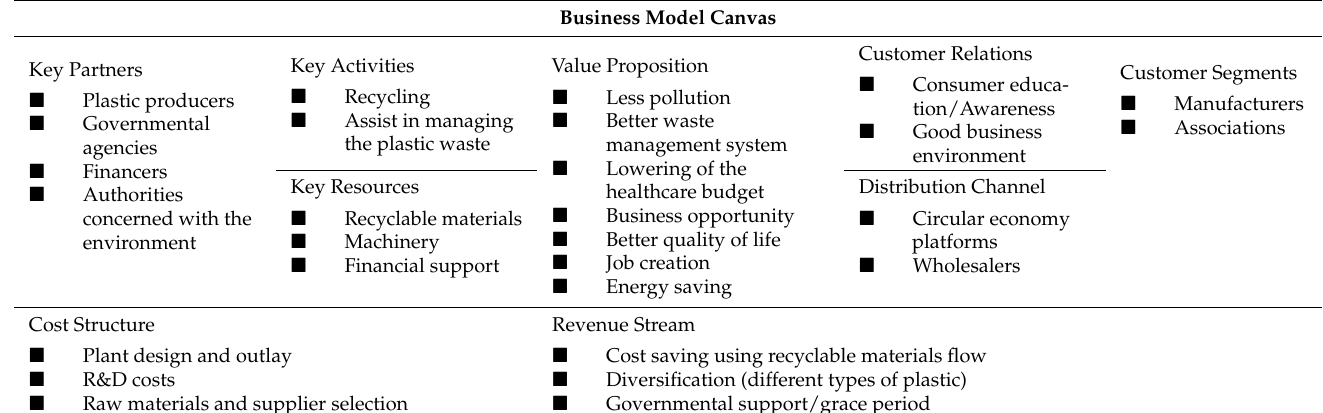
Table 2. Business Model Canvas.